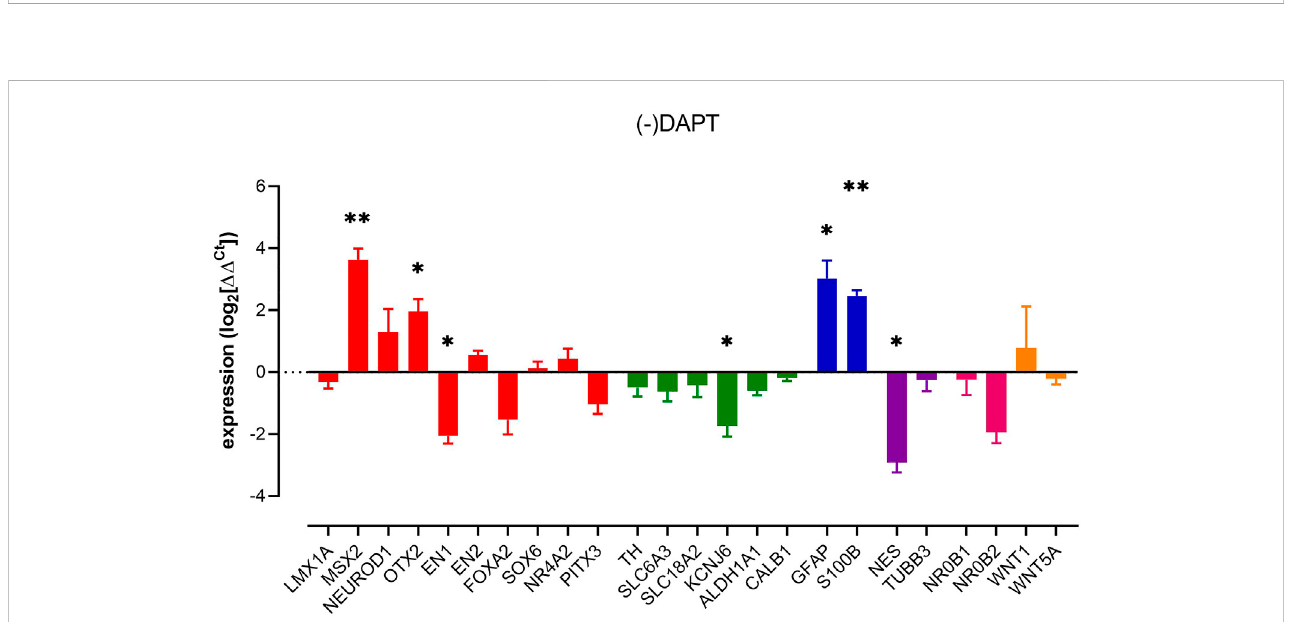
FIGURE 3 Impact of removal of DAPT upon pluripotent stem cell-derived dopaminergic neuron cultures. Columns show mean (+s.e. mean) data normalized to HPRT1 and TBP and expressed as fraction of (+) DAPT control (from matched differentiations). Statistical analysis was via one sample t-tests ( n = 3 biological replicates). Graphs show mean +/- s. e. mean changes; * = p < 0.05, ** = p < 0.01, and *** = p <